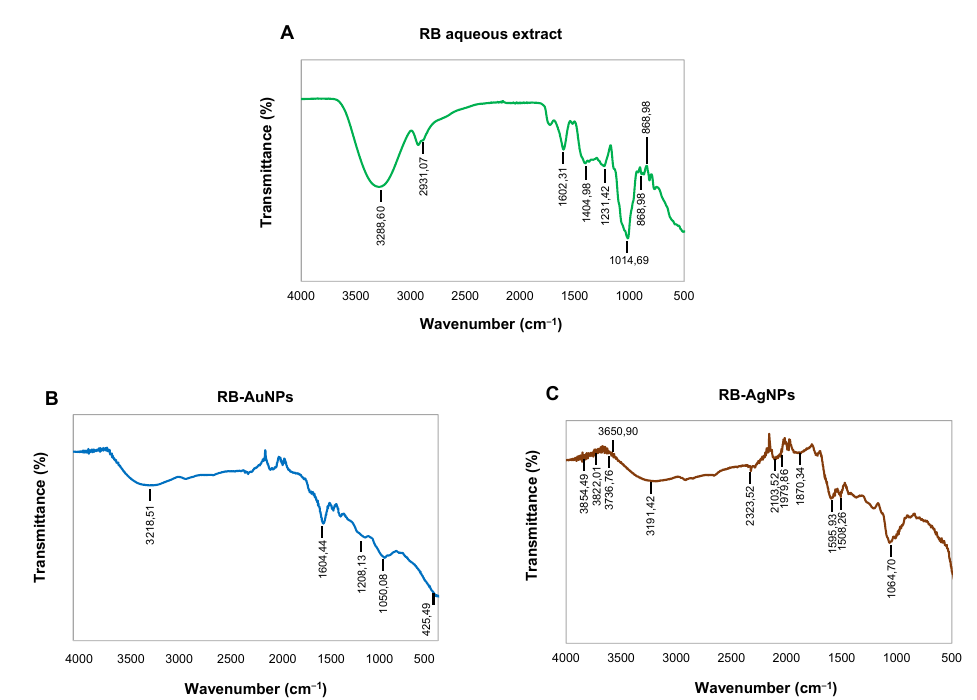
Figure 6. FT-IR spectrum of ( A ) freeze-dried aqueous extract of rowanberries and ( B ) RB-AuNPs, and ( C ) RB-AgNPs, which demonstrated the active surface groups for respective samples.